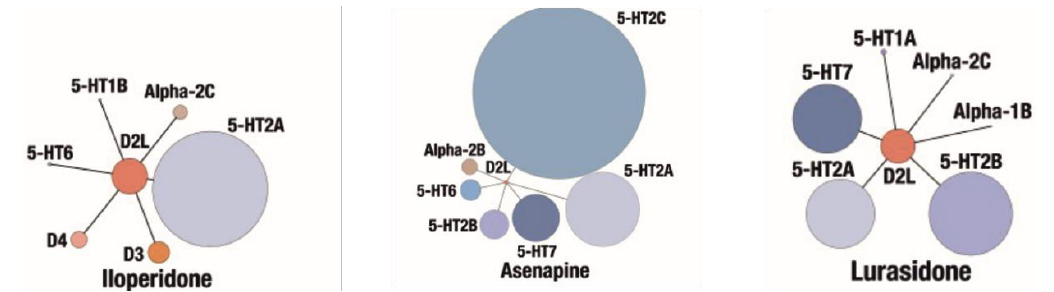
Figure 5. Pharmacological profiles of some new second generation antipsychotics, elaborated on the basis of [90] with modifications.